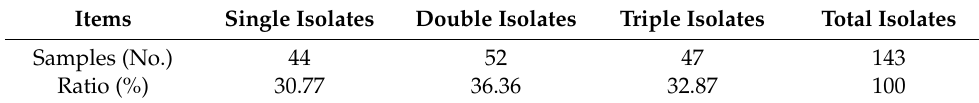
Table 3. Pathogen infection pattern of 143 positive isolation.